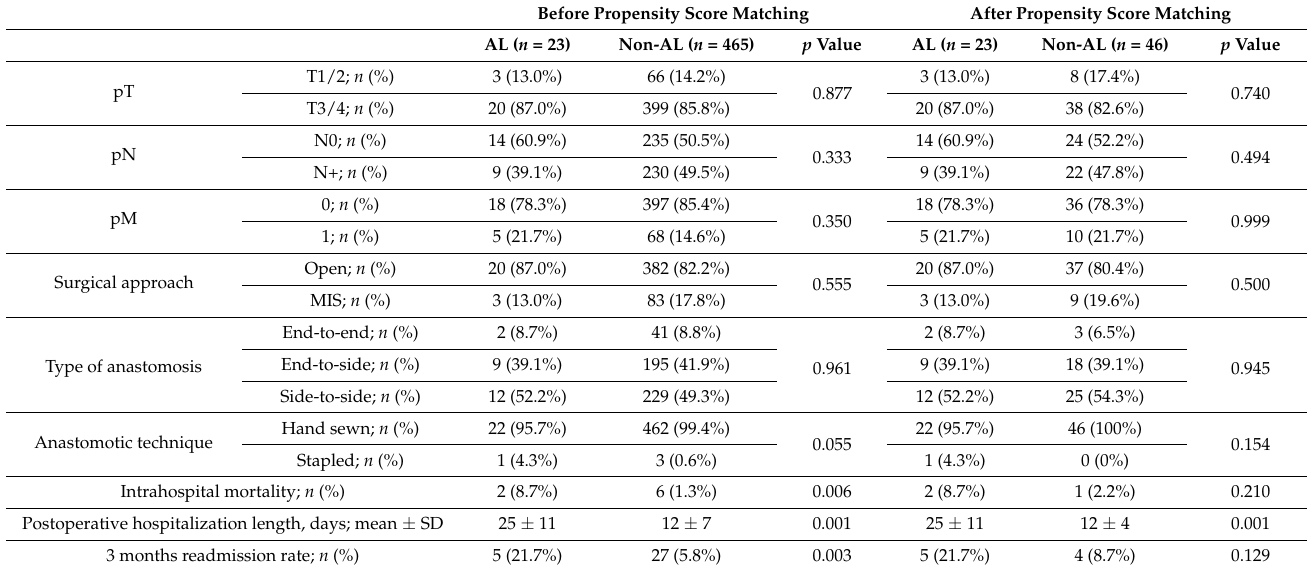
Table 3. Univariate Cox regression analysis for overall and disease-free survival in the propensity- score-matched cohort.